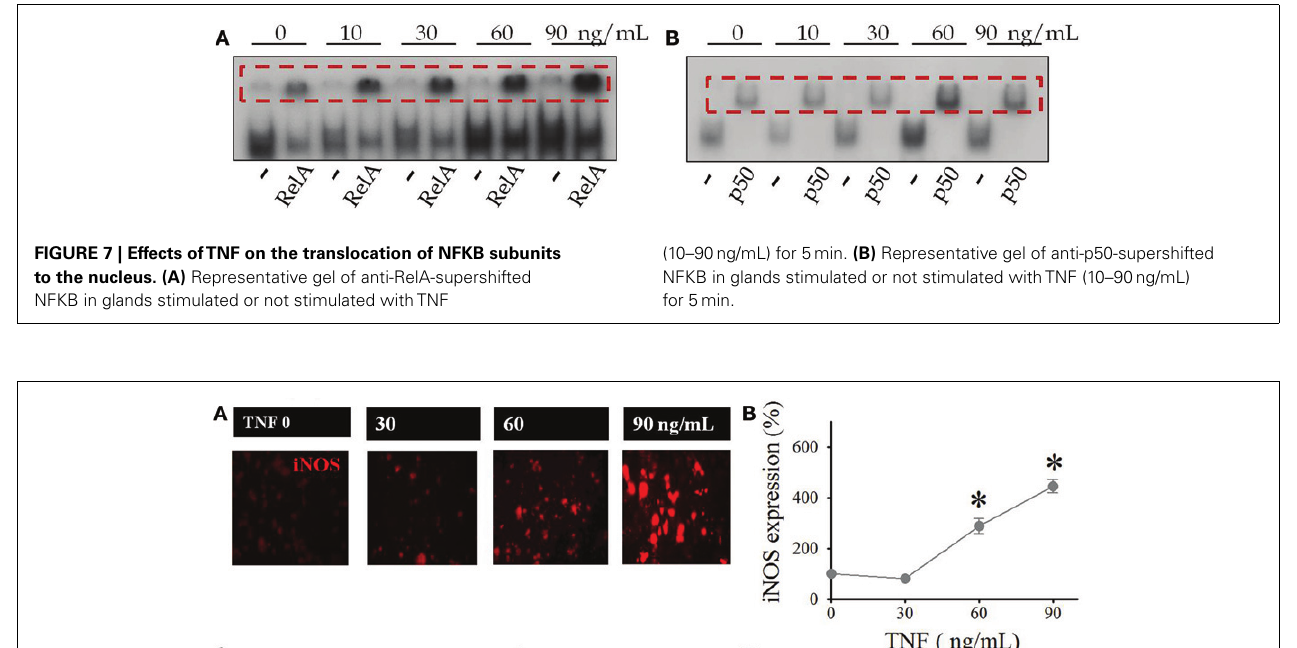
FIGURE 8 |Tumor necrosis factor-induced iNOS expression and NO production in cultured pinealocytes. (A) Representative immunocytochemistry images showing staining against iNOS (red) in pinealocytes stimulated or not stimulated withTNF (30–90ng/mL for 120min). (B) Quantification of the fluorescence intensity. (C) TNF (120min)–induced iNOS expression is inhibited by